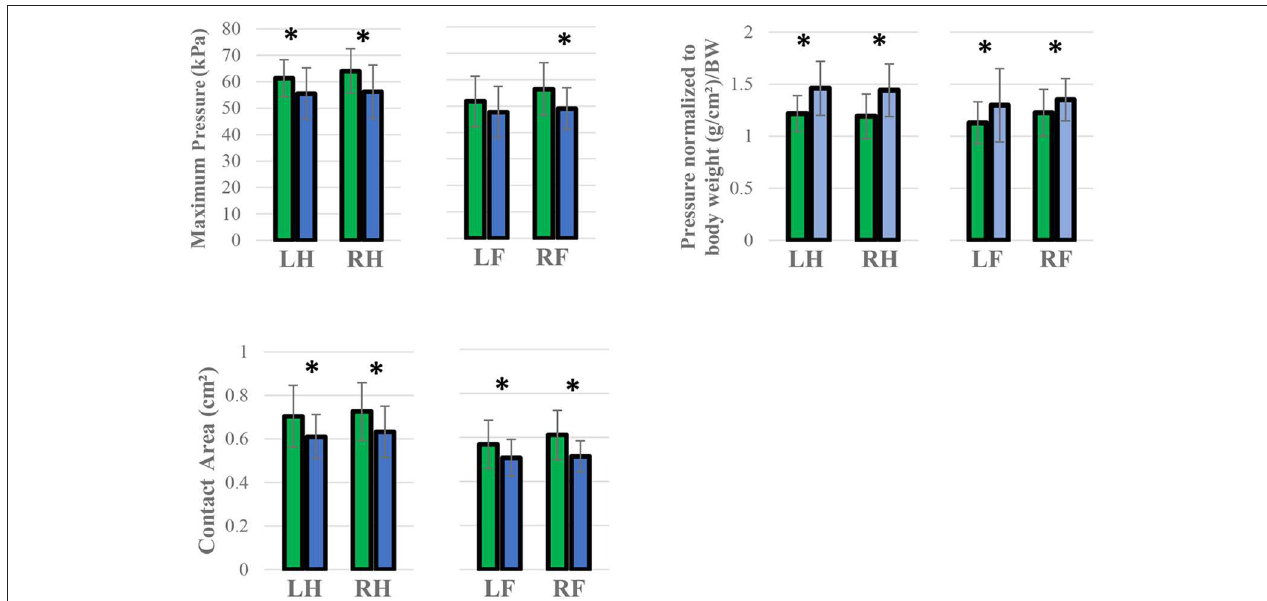
FIGURE 5 | Analysis of variance of gait variables. Two-way ANOVA * P < 0.05 analysis. Comparison of the mean values between Lewis Rats (LR) and Sprague Dawley rats (SD), subcategorized by left forelimb (LF), right forelimb (RF), and left hindlimb (LH), and right hindlimb (RH). All values are presented as group means and SD error bars. * P <